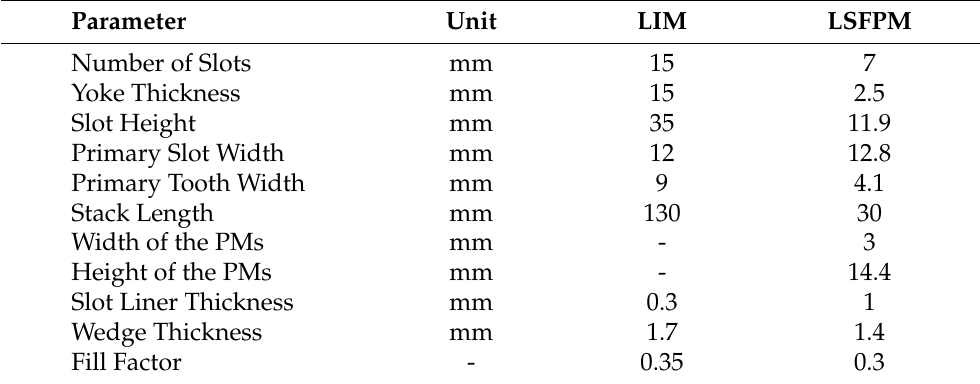
Table 7. Main parameters of the prototypes for the thermal